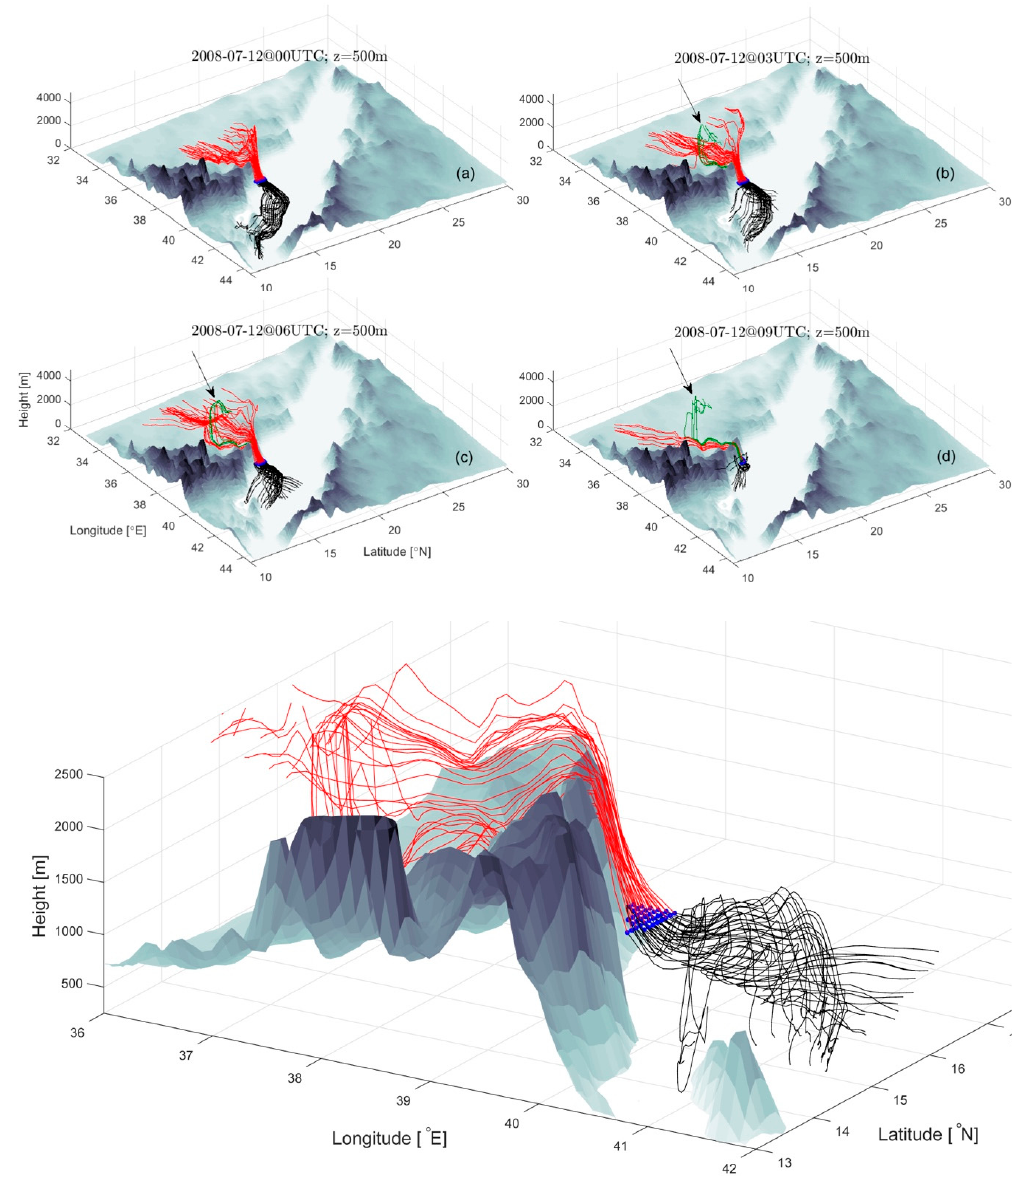
Figure 13. Similar to Figure 11, but the trajectories are released at z = 500 m in the outflows of the Gap 2 (the gap immediately to the south of the Tokar Gap) over an area where the wind speed exceeds 15 m / s. As in Figure 11, arrows point to (green) trajectories that originate from the upstream cell. Frame e is an enlarged and a slightly rotated version of frame c . The upstream portions of some trajectories appear discontinuous because they spent time above the upper boundary of the plot